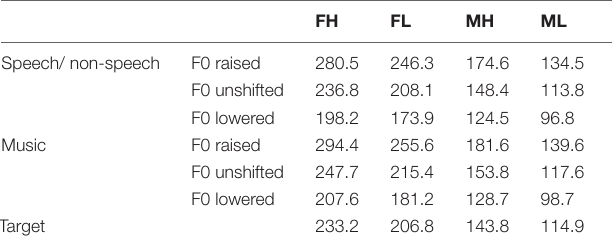
TABLE 1 | Mean fundamental frequency (Hz) of speech contexts, their counterparts, and targets. FH FL MH